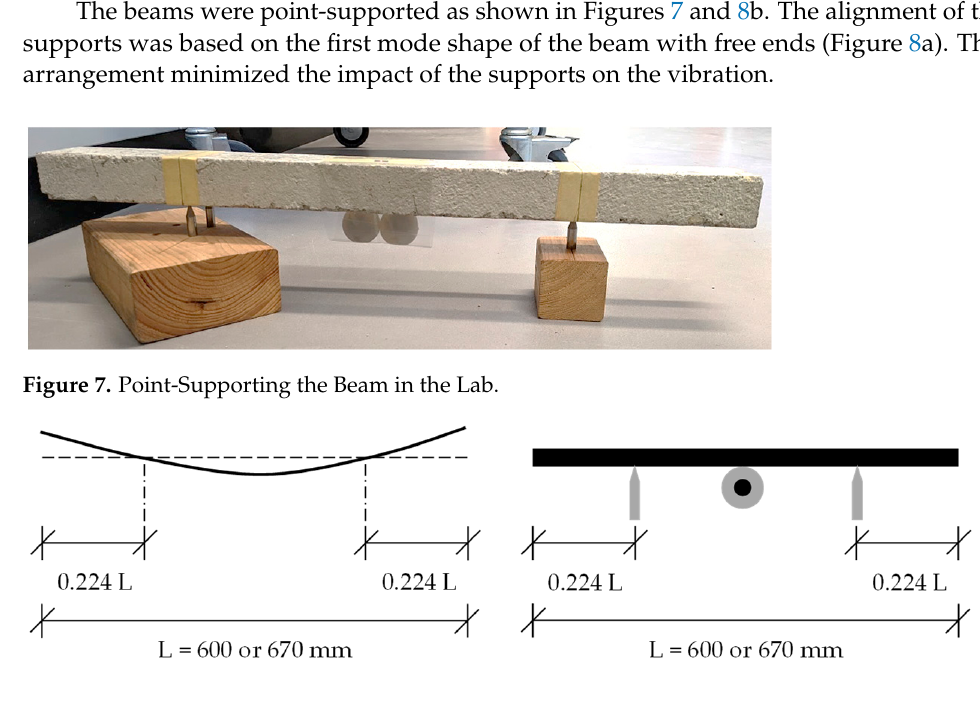
Figure 9. An overall view of the test setup.